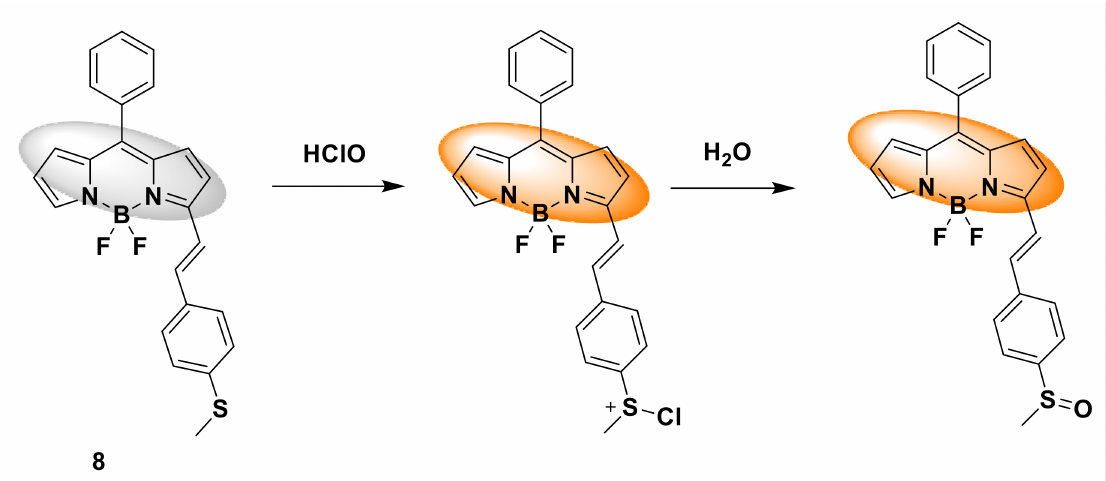
Figure 9. The reaction of probe 8 and HClO.